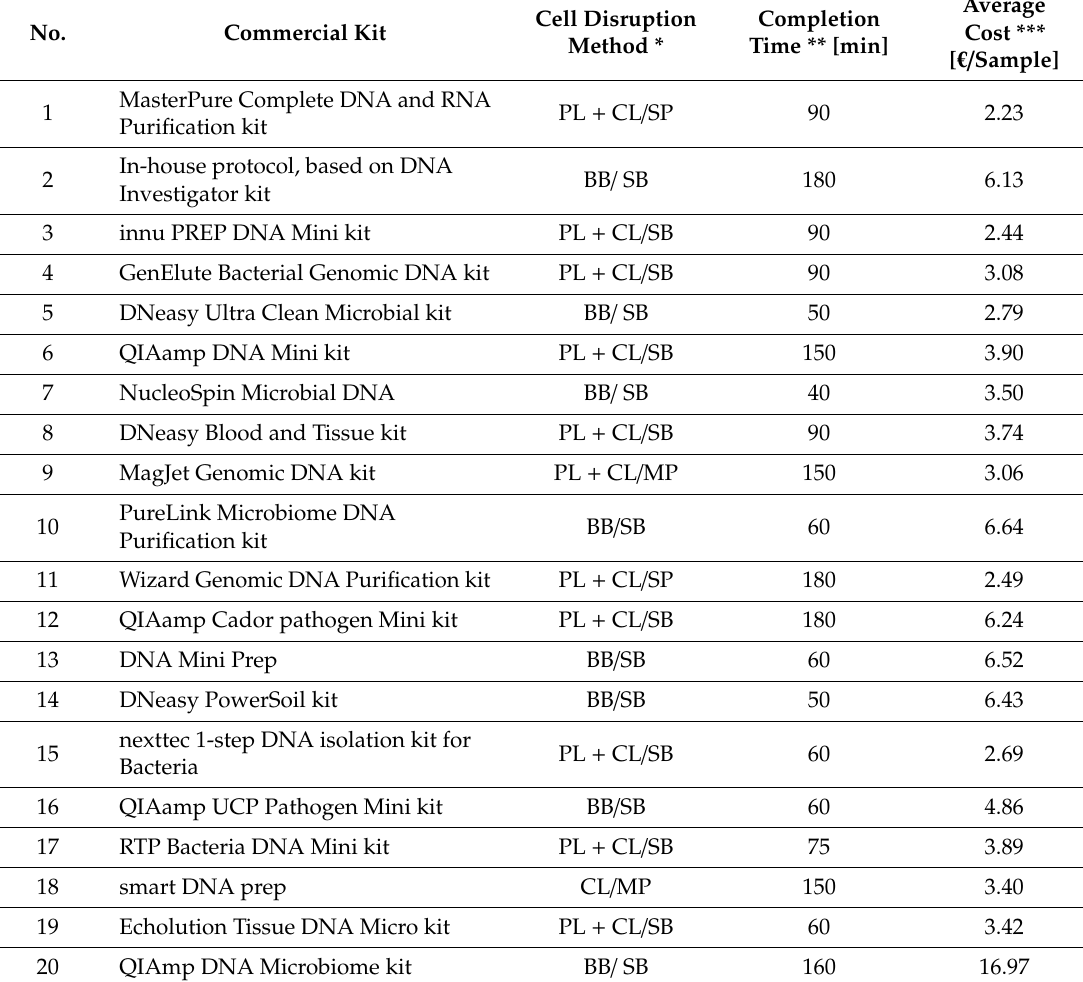
Table 3. Characteristics of the 20 commercial DNA extraction kits